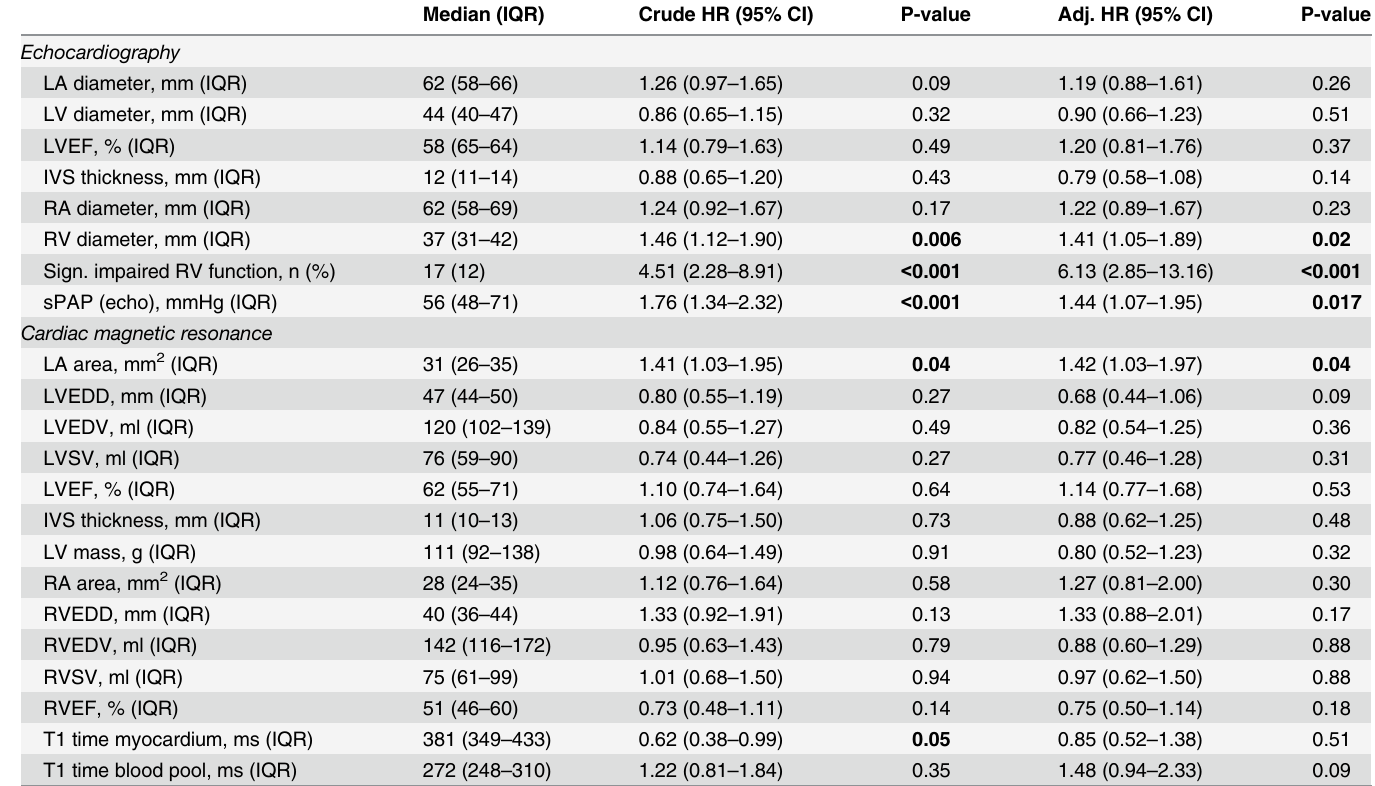
Table 2. Cox proportional hazard models of non-invasive imaging measurements in patients with HFpEF (n = 142). Hazard ratios (HR) refer to a 1-SD increase in continuous variables. HRs are adjusted (adj.) for all variables in the clinical confounder model i.e. diabetes, COPD, and